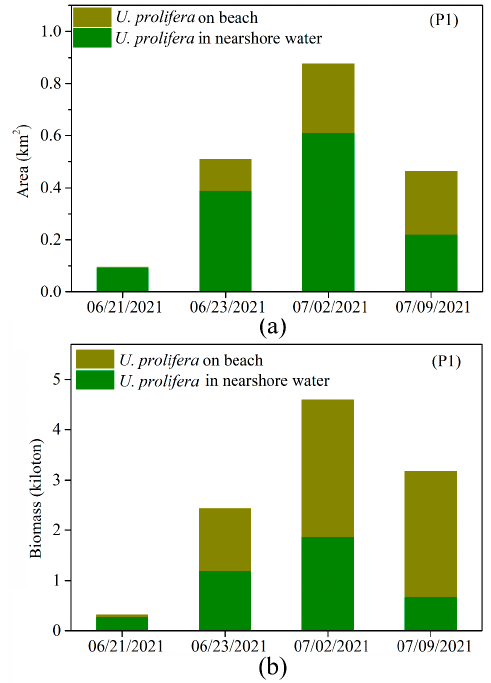
Figure 8. The statistical results for coverage area and biomass of U. prolifera in the P1 area. ( a ) The statistical results for the coverage area of U. prolifera on the beach and in nearshore water; ( b ) the statistical results for the biomass of U. prolifera on the beach and in nearshore water.